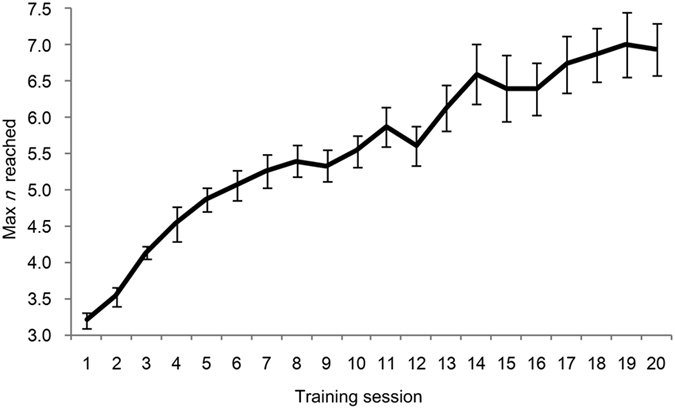
The max n reached on the dual n-back task across the 20 training sessions in the training group.Error bars represent standard error.